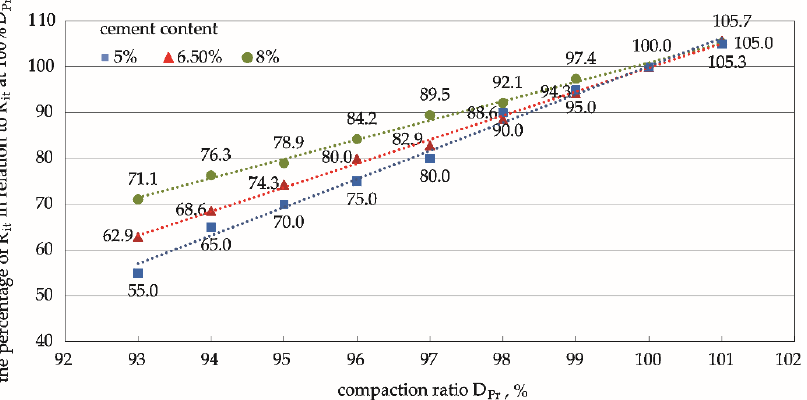
Figure 12. Corresponding relationships between the percentage of indirect tensile strength, R it , under different compaction ratios in relation to R it at 100% D Pr . Cement content: — 5%, — 6.5%, — 8%.